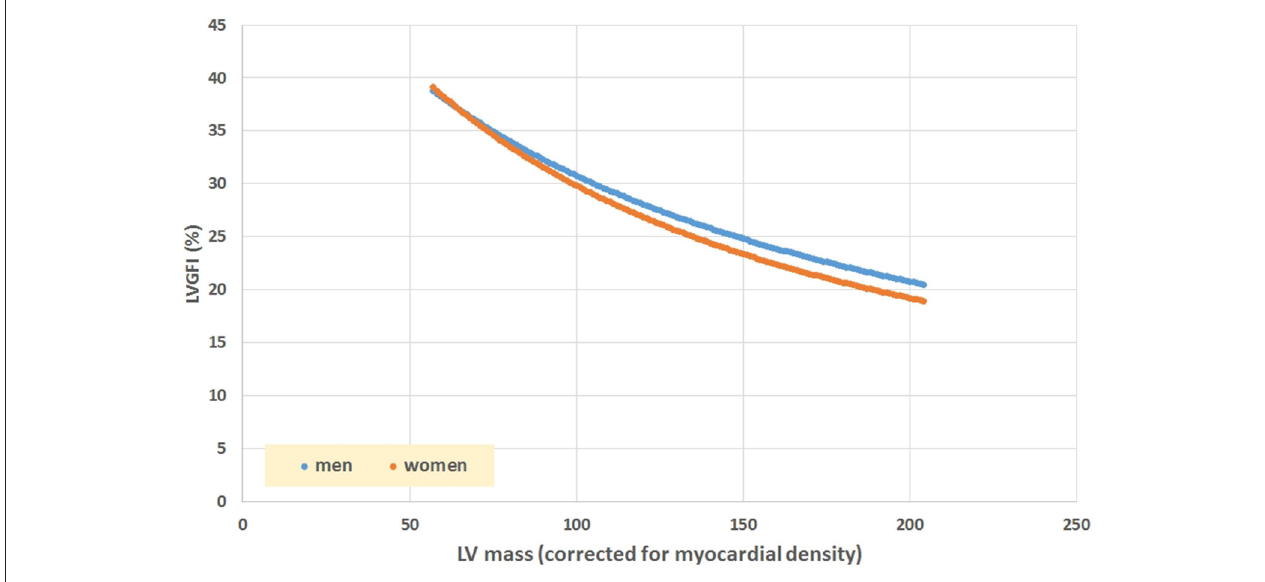
ESV)/2 as obtained in our +